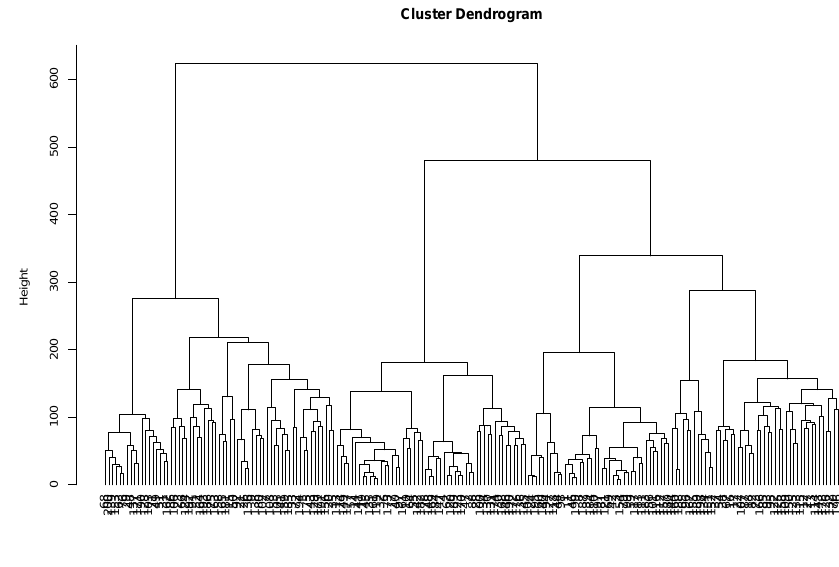
Figure 11. Dendrogram obtained from the WER dissimilarity matrix.